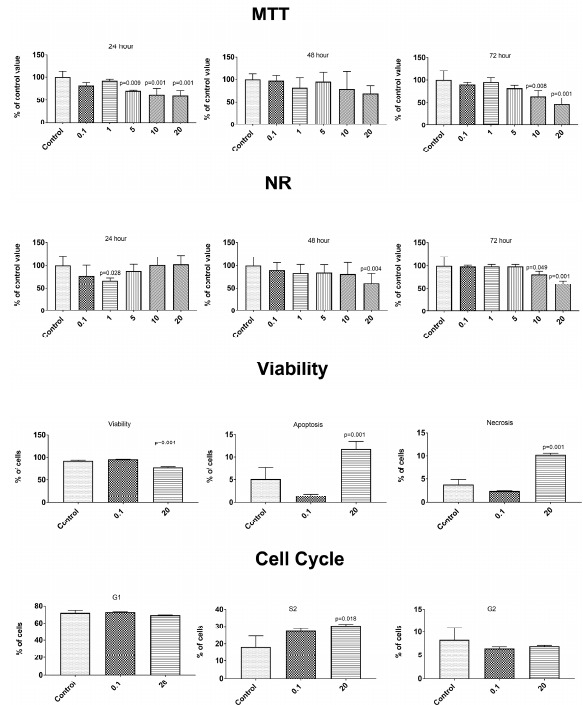
Figure 3. Impact of C-GD (sample after the in vitro digestion of the control lovage leaves) on cytotoxicity (MTT and NR method), type of cell death (Annex V and propidium iodide (PI) test), and the phases of the cell cycle in the healthy prostate epithelial cell (HPrEC) ATCC ® PCS-440-010 ™ cell line.